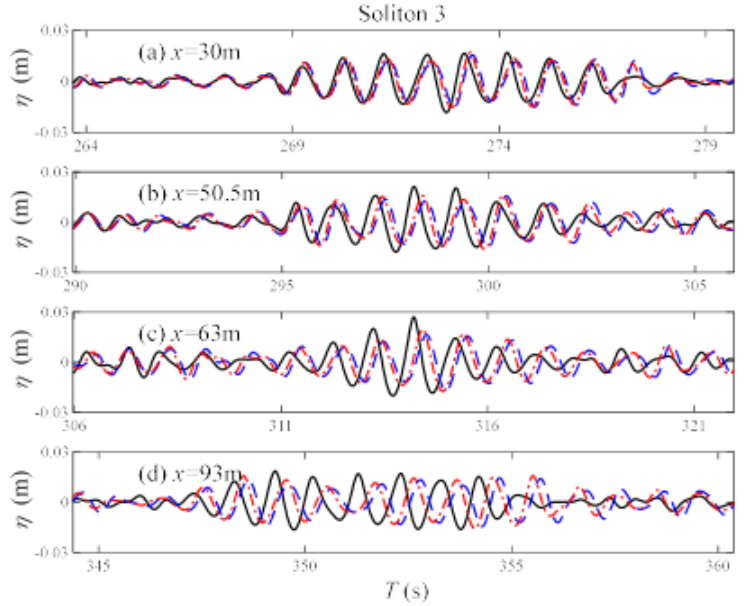
Figure 9. Comparison of Soliton 3 between different nonlinear orders. The blue dashed lines correspond to the simulation with only linear effects ( M = 1). The red dashed dot lines correspond to the simulation with second harmonic effects ( M = 2). The black solid lines correspond to almost fully nonlinear simulations ( M = 6).